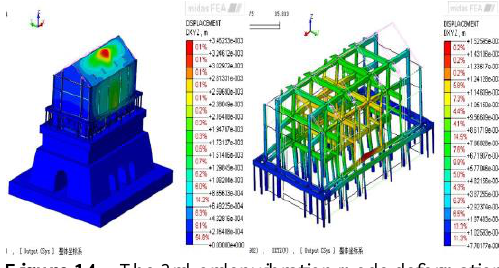
Figure 14. The 3rd-order vibration mode deformation 3.6.4.2 Effective stress calculated structure Earthquakes ： Deformation of the first vibration mode (oscillation mode) is the